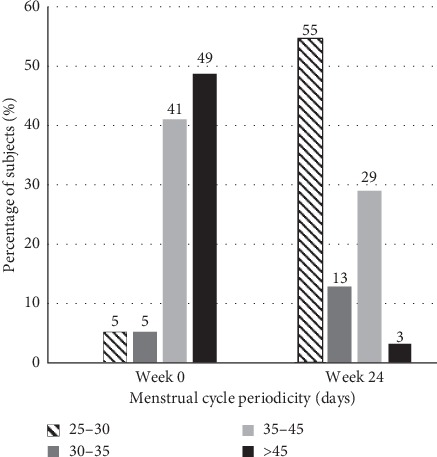
Distribution of menstrual cycle variation among the subjects during the study period. The different bar patterns represent the menstrual cycle distribution in days among the patients having 25–30-day, 30–35-day 35–45-day, or >45-day cycle, respectively. The enrolled patients displayed normal hormonal levels.